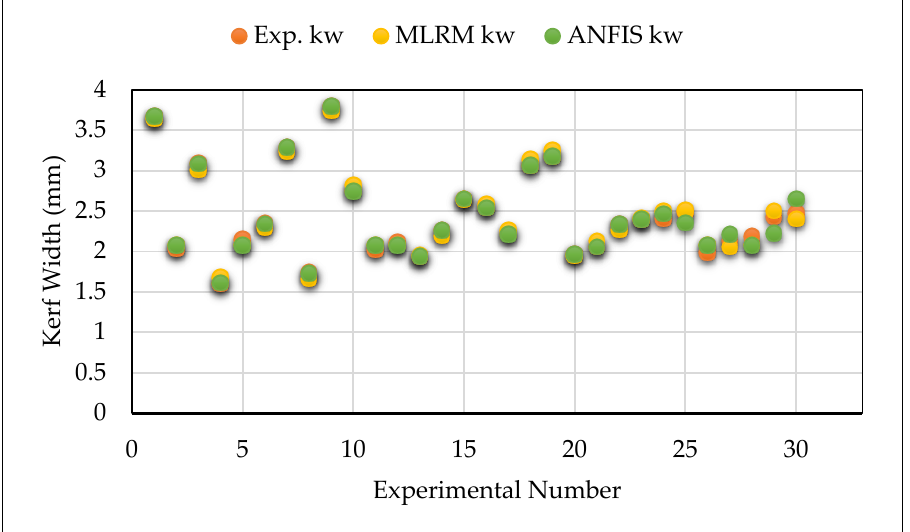
Figure 9. Comparison of ANFIS and MLRM predicted vs. experimentally measured kerf width values.